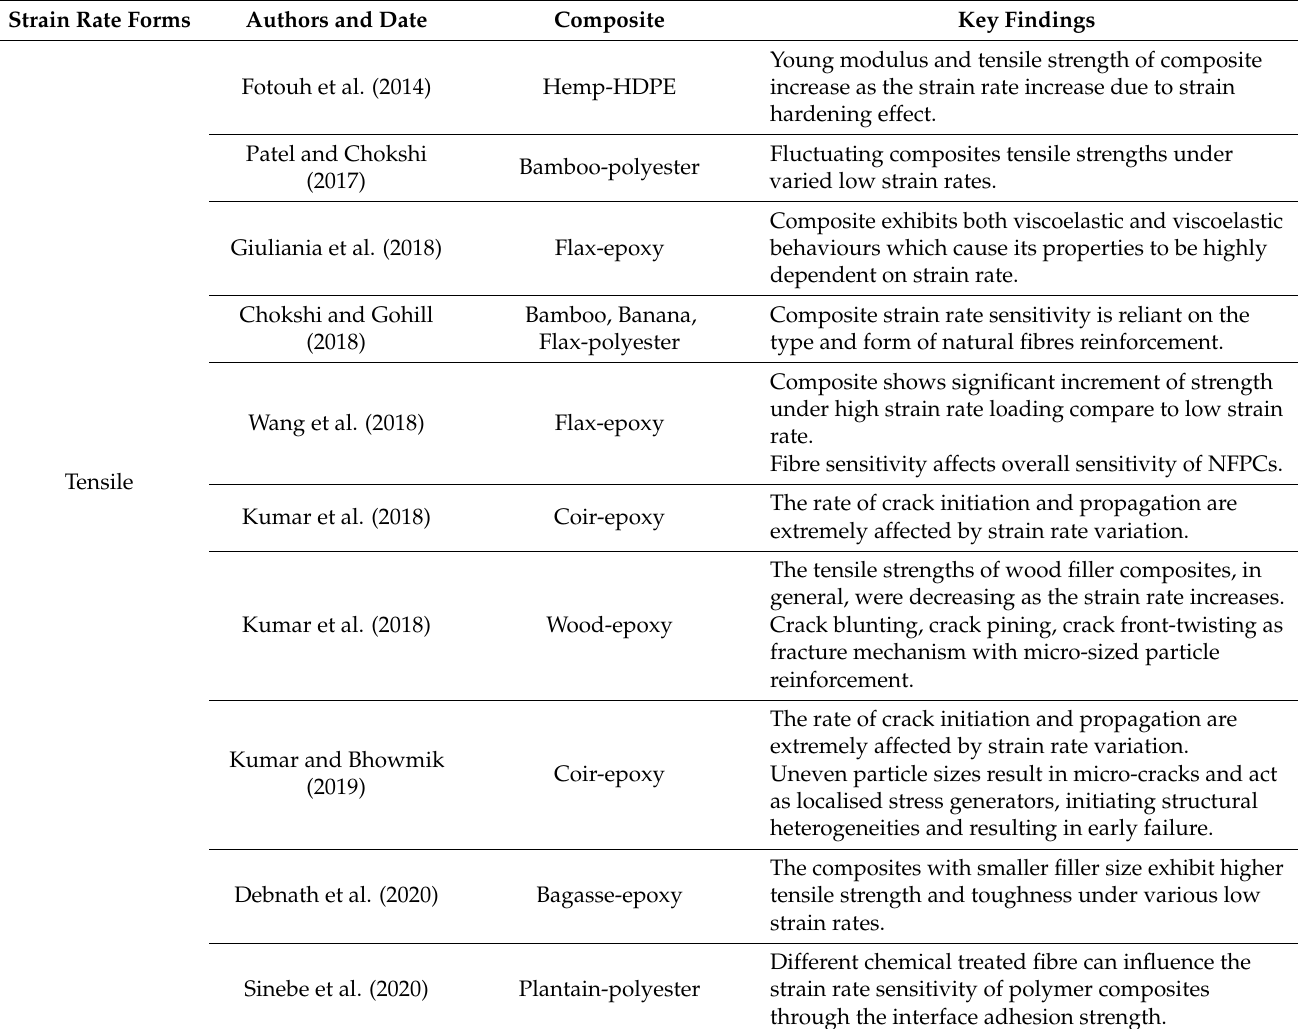
Table 2. Summary of key findings from literature regarding